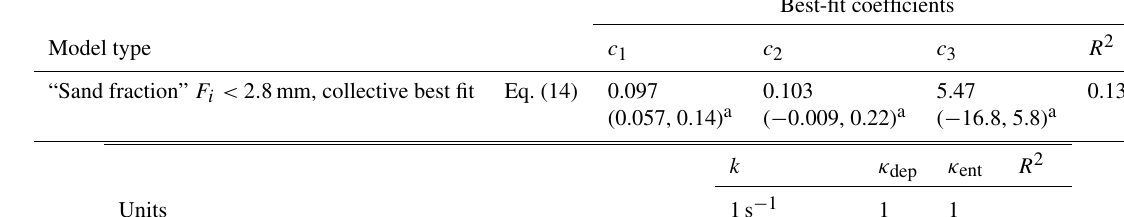
Table 1. Best-fit threshold evolution models. Model type “Sand fraction” F i < 2 . 8mm, collective best